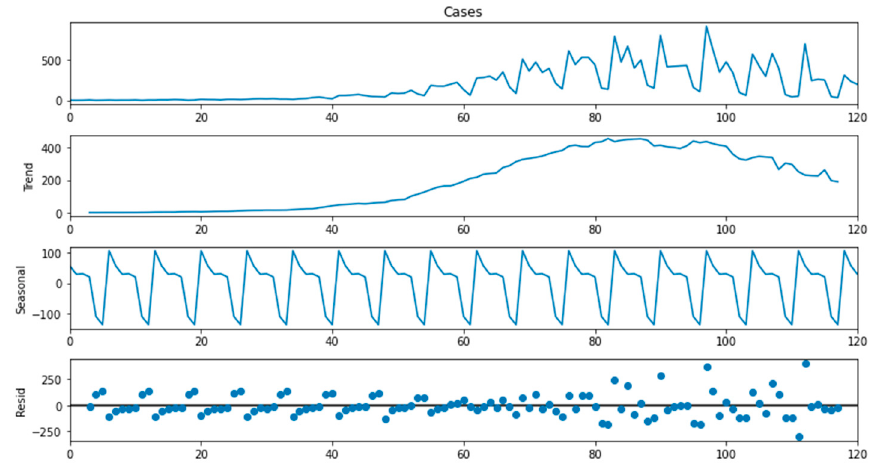
Figure 3. Decomposition of reported Monkeypox cases from 17 May 2022 to 14 September 2022 in the USA.